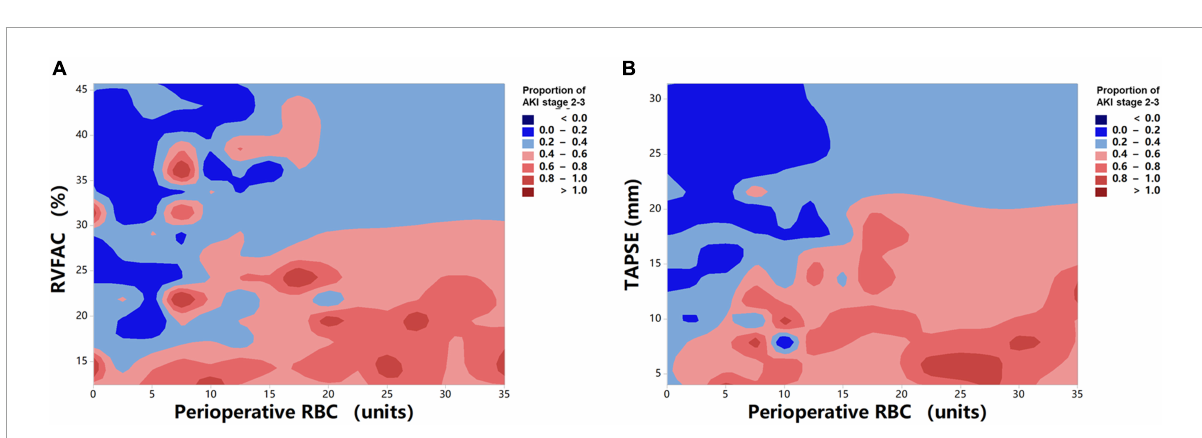
FIGURE5 Contour plot of the risk of moderate to severe AKI in patients with HTx. Decreased RVFAC (A) and TAPSE (B) are associated with an increased risk of moderate to severe AKI, which is pronounced in patients with more perioperative RBC